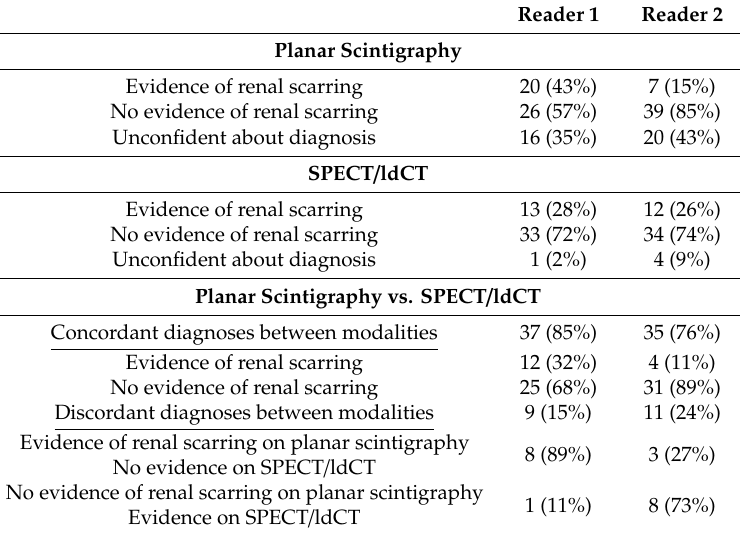
Table 1. Assessments of DMSA scintigraphies by Reader 1 and Reader